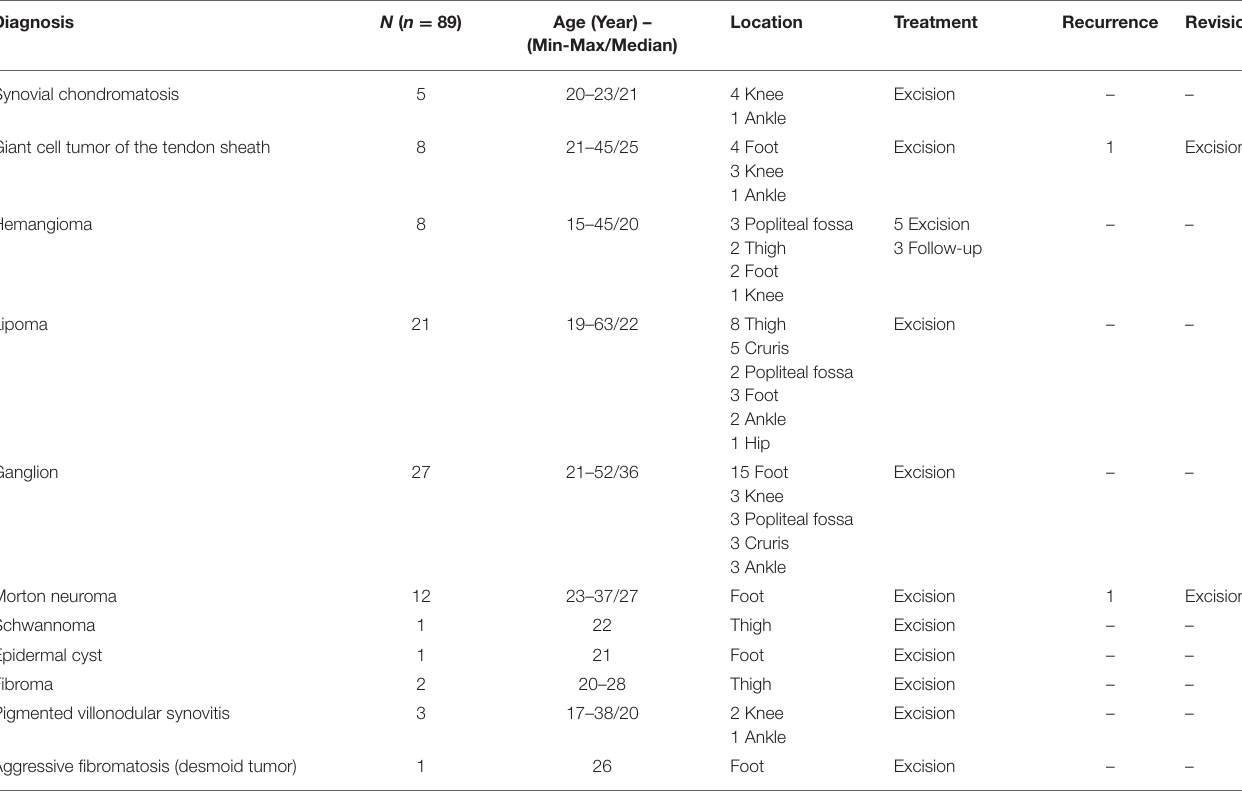
TABLE 6 | Benign soft tissue tumors of the lower extremity.